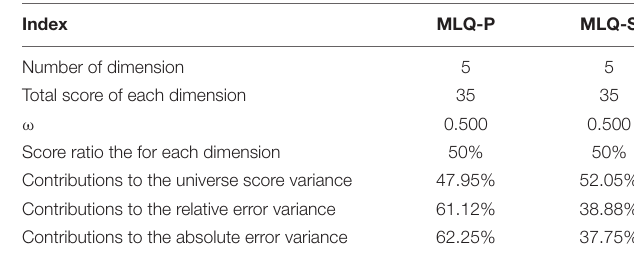
TABLE 4 | Contribution ratio of each dimension to the universe score of